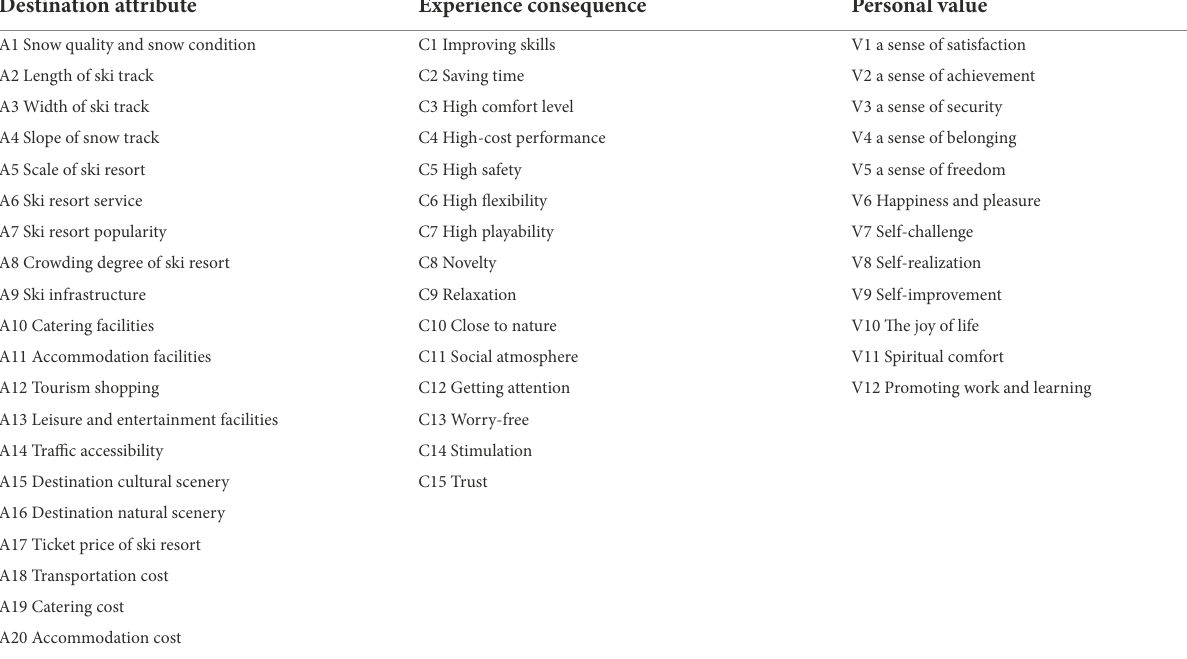
TABLE 1 Measurement items of influencing factors for destination choice of ski tourism enthusiasts. Destination